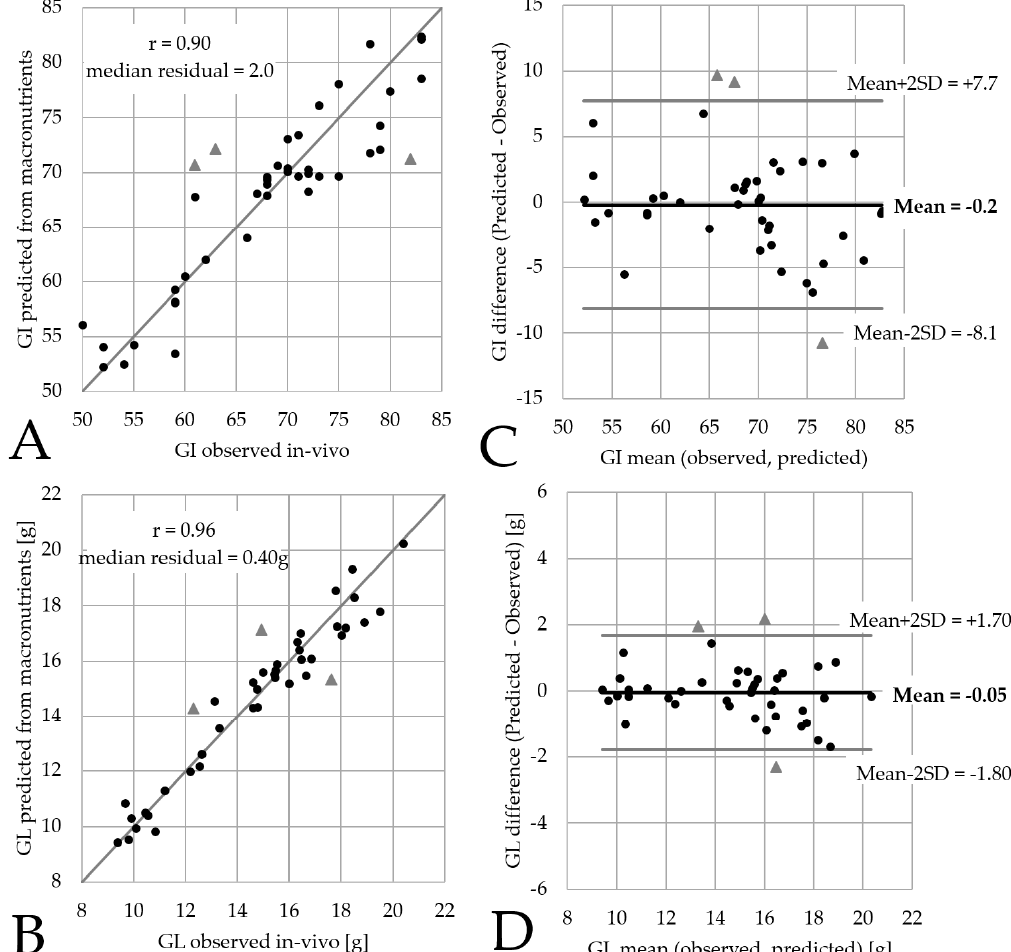
Figure 1. Macronutrient predictions vs. in-vivo data for 42 breakfast cereals with ( A ) observed vs. predicted GI, ( B ) observed vs. predicted GL, ( C ) GI Bland-Altman plot ( D ) GL Bland-Altman plot